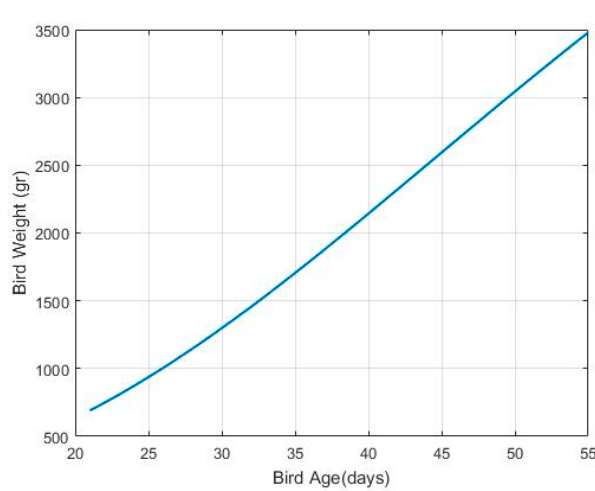
Figure 2. Weight growth curve.